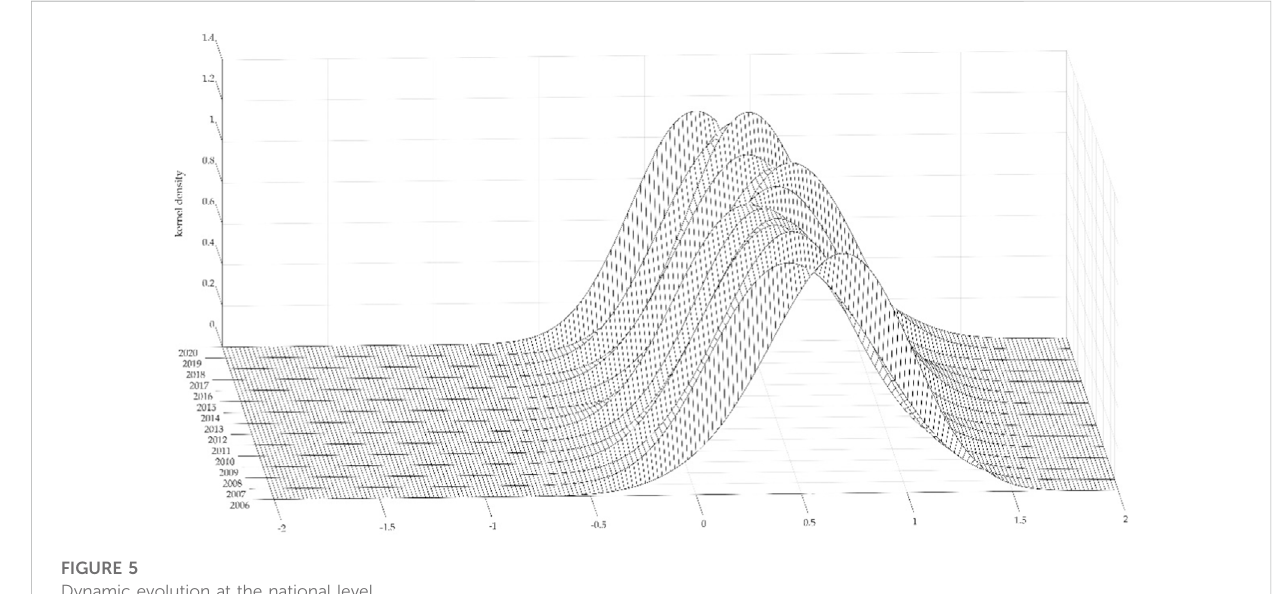
FIGURE 5 Dynamic evolution at the national level.